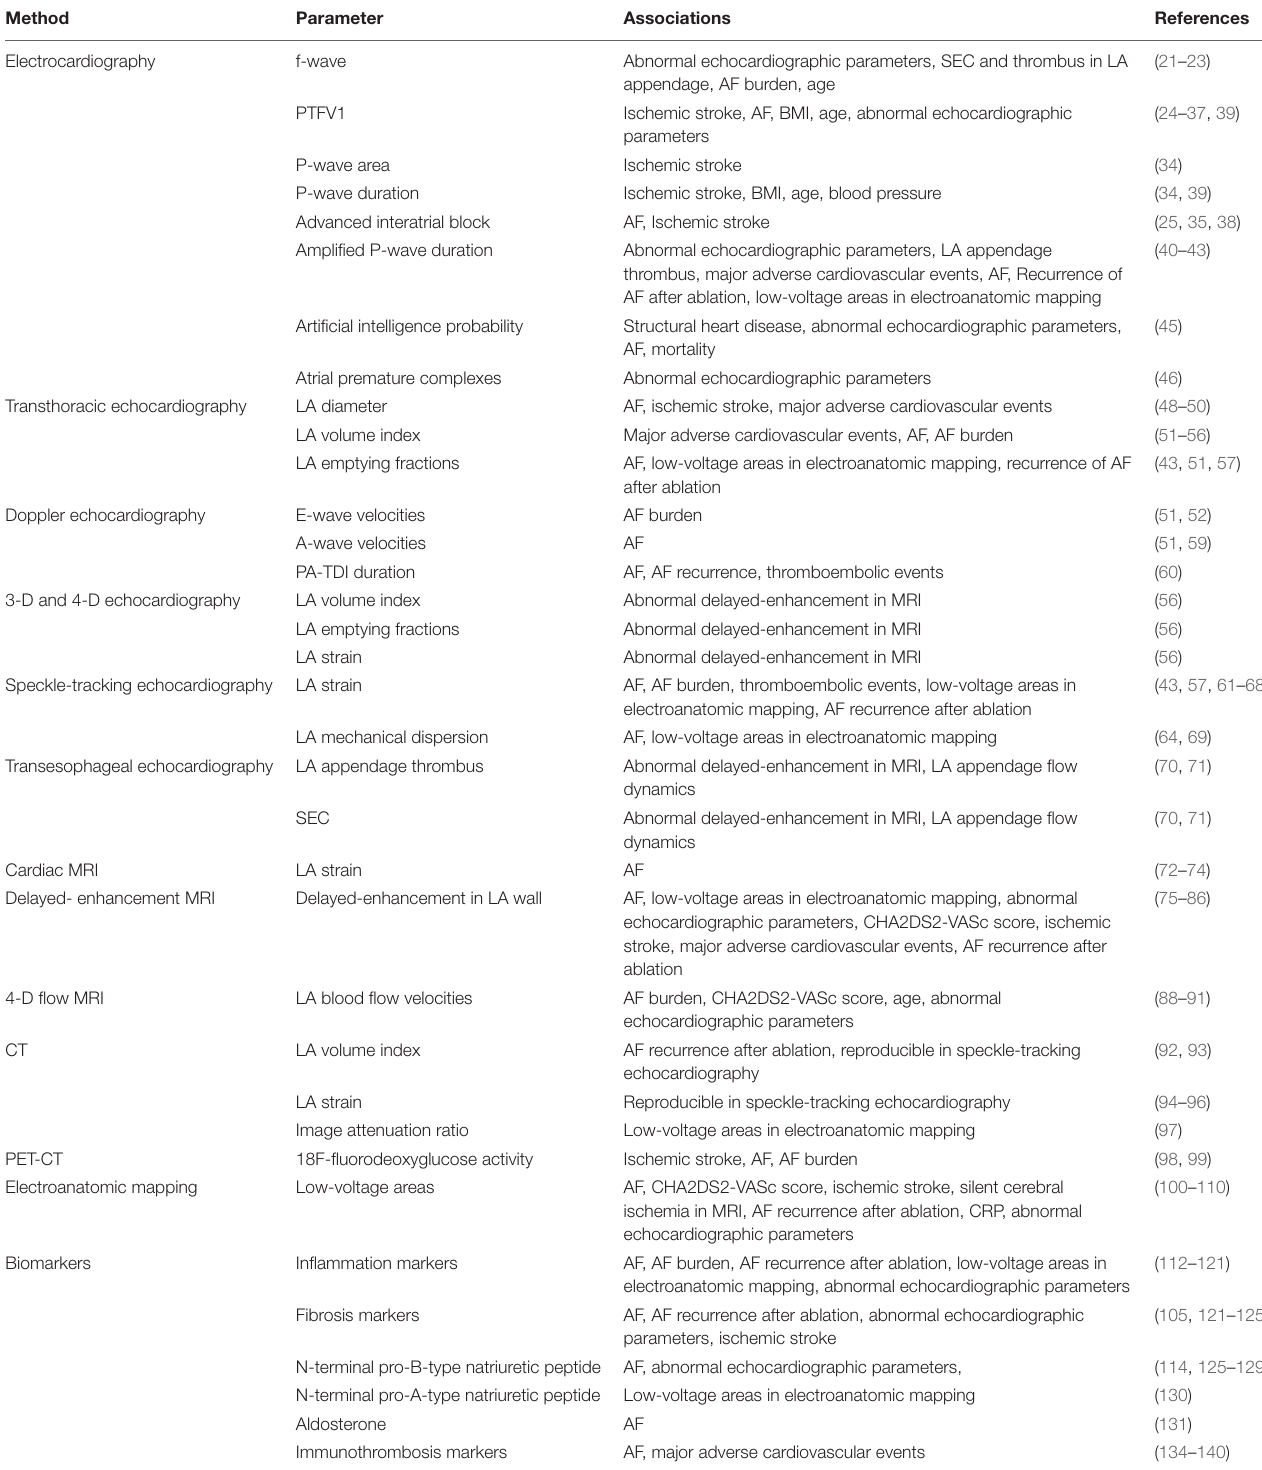
TABLE 1 | Overview of different methods and variables for the assessment of LACM, and their associations to clinical outcomes and abnormal